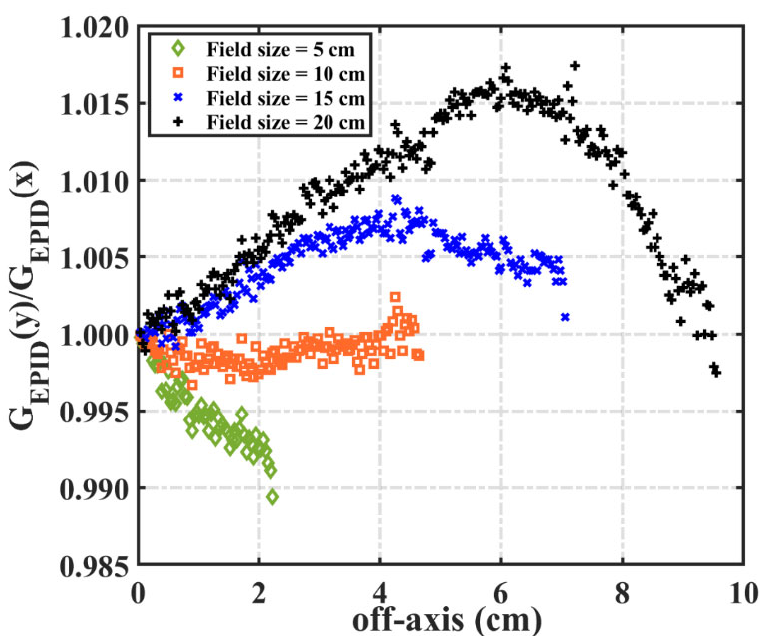
Figure 9. The ratio of the EPID pixel values in the negative inline and crossline directions. The off-axis response of the EPID image changes after dark field and flood field calibration. Renner et al. [28] measured the in ‐ air profile of a 40 × 40 cm 2 field using the ionization chamber as the off ‐ axis response correction curve, and Camilleri et al. [25] used